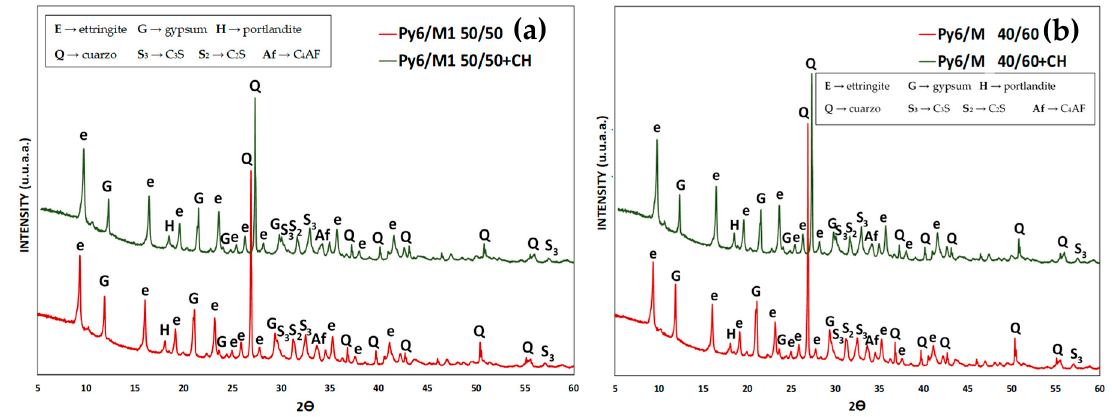
Figure 6. XRD patterns. ( a ) P1 / M 50 / 50 and PY6 / M 50 / 50 + CH. ( b ) P1 / M 40 / 60 and PY6 / M 40 / 60 + CH. L-A specimens at 28-days.